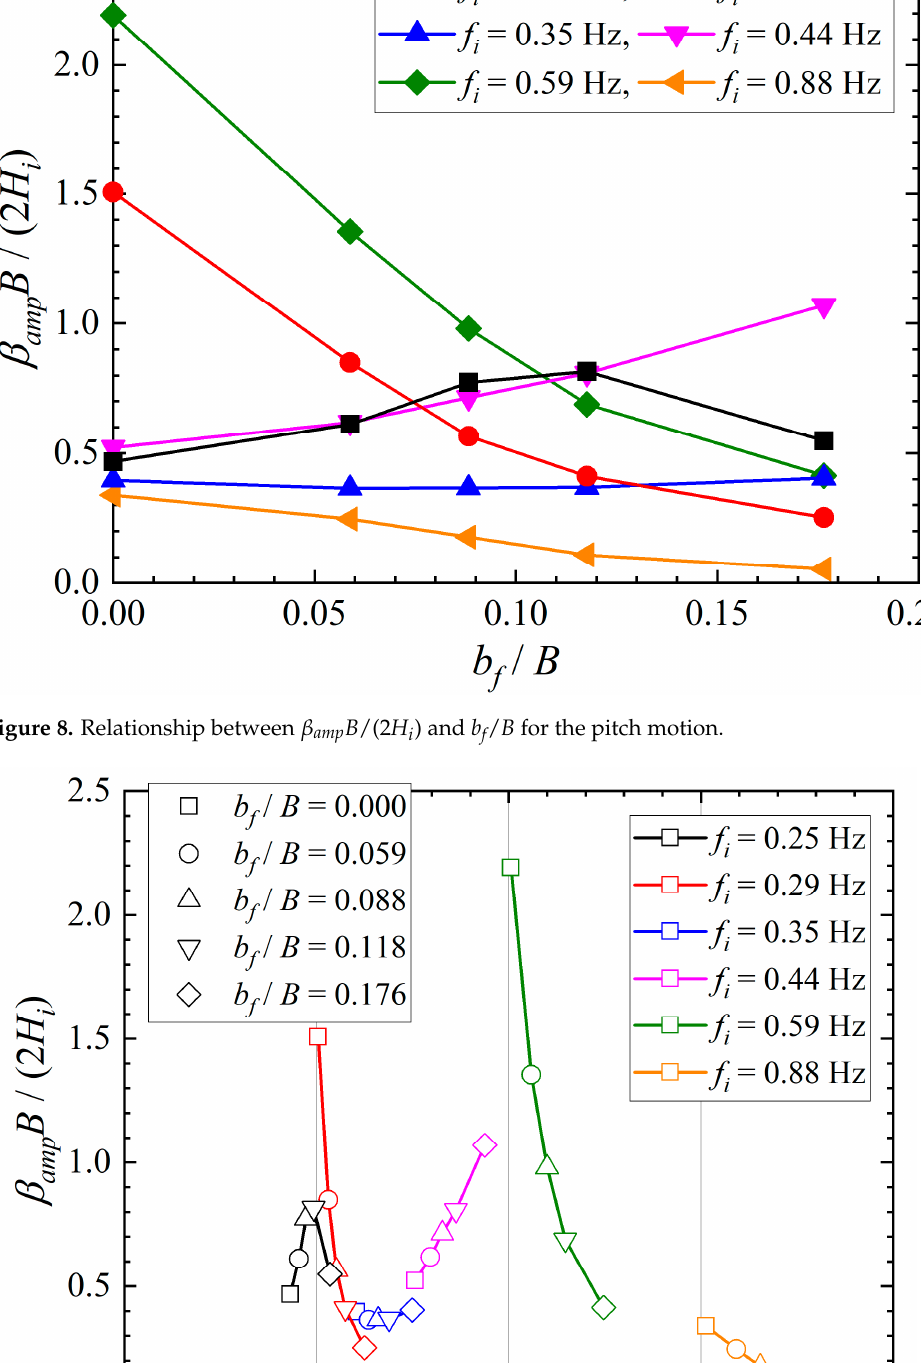
Figure 9. Relationship between β amp B /(2 H i ) and f i / f pitch for the pitch motion.